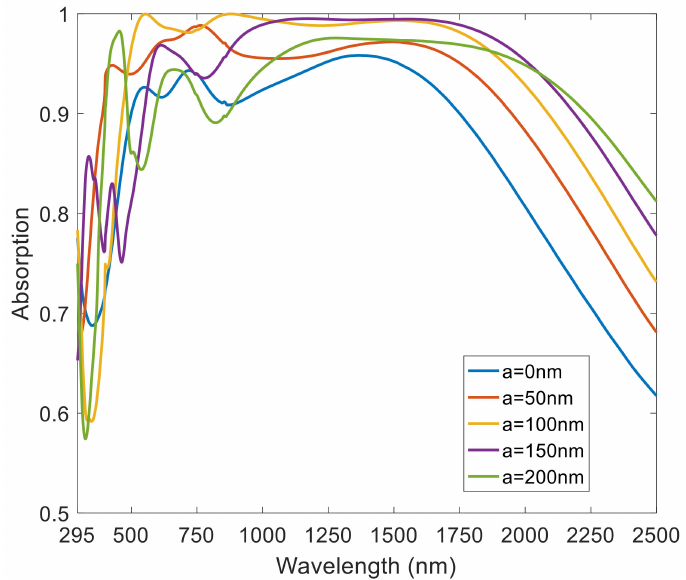
Figure 7. Normalized absorption spectra under different thicknesses of the anti-reflection